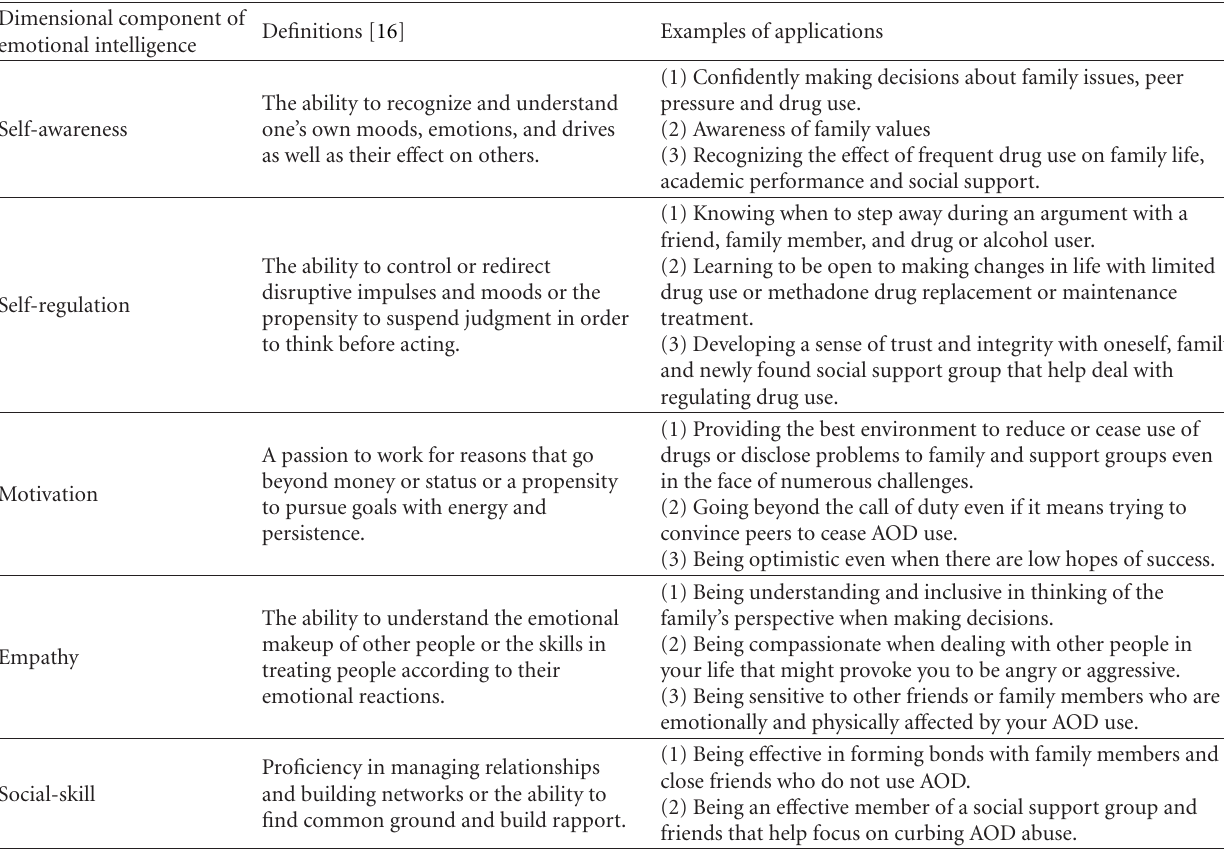
Table 1: Emotional intelligence applications to AOD